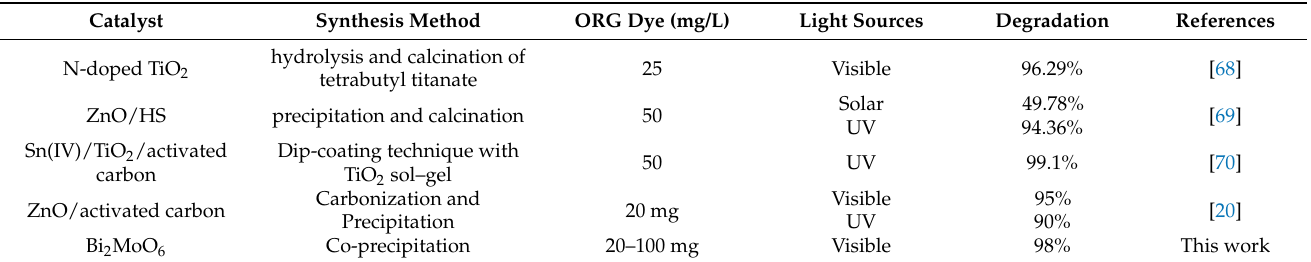
Table 3. Comparative results of ORG dye degradation by various catalyst.